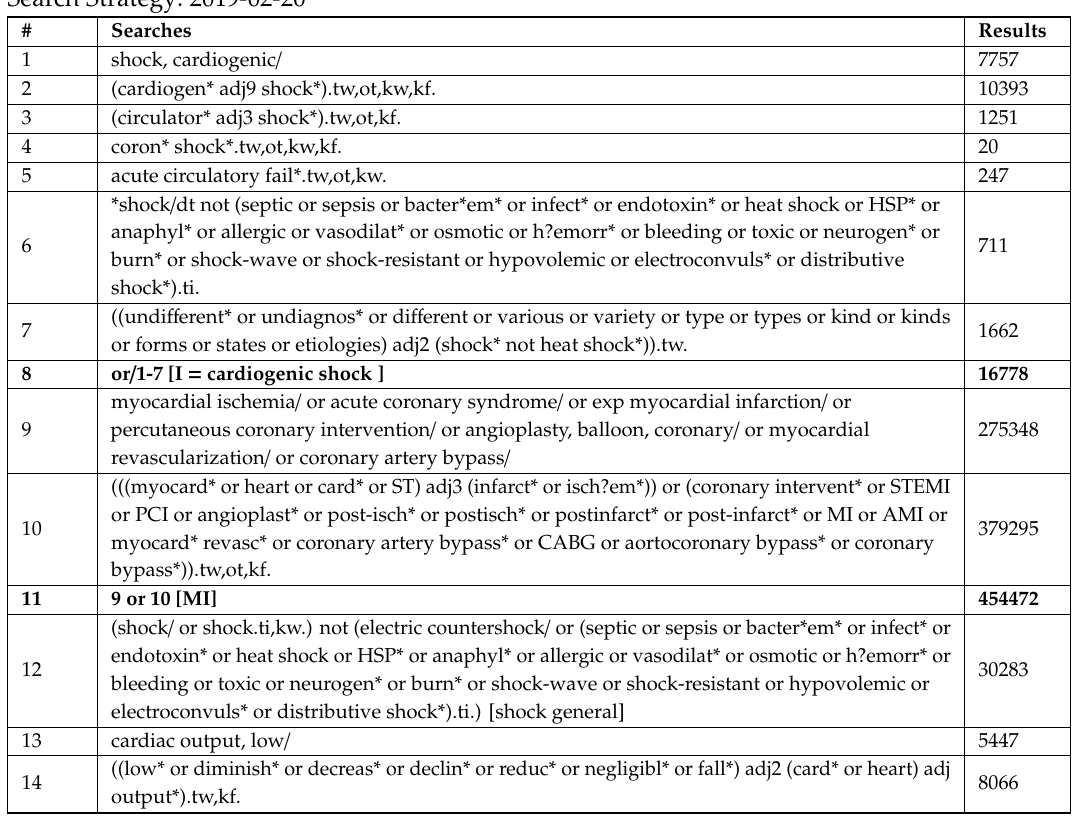
Table S1: Overall patient population and baseline characteristics. Table S2: Quality assessment of the randomized trials. Table S3: Quality assessment of the observational studies. Table S4: Mortality outcomes for cardiogenic shock population. Table S5: Primary and secondary outcome(s) of the included